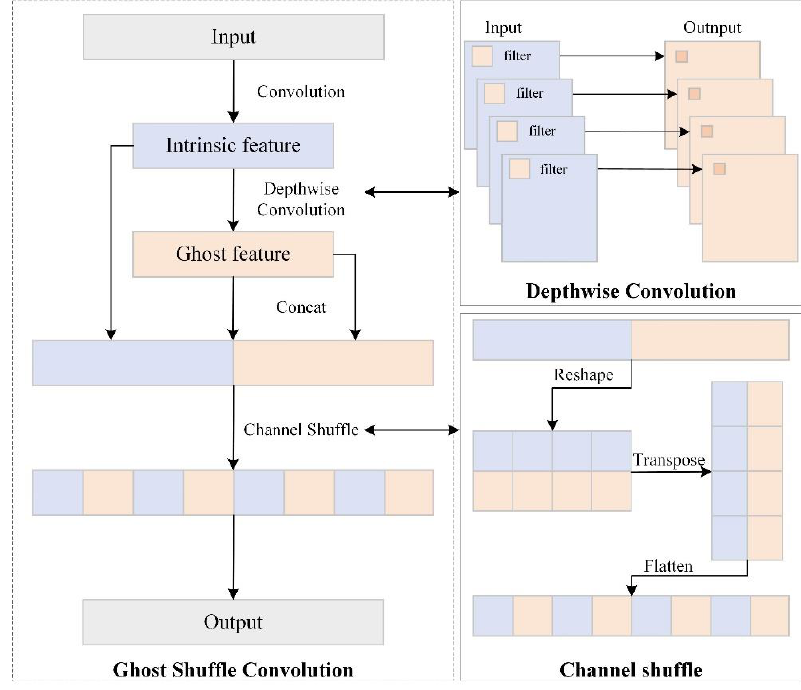
Figure 3. Structure of the DWC and GSC